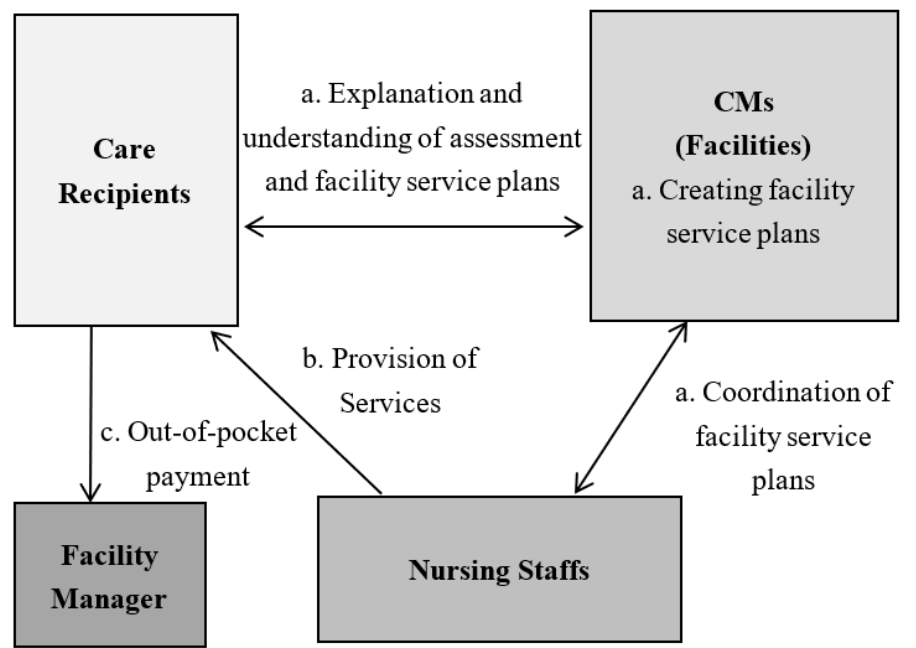
Figure 4. Workflow of CMs regarding services offered used at facilities. Source: Ministry of Health, Labour and Welfare. Instructions for Care Managers, 2023 [11].